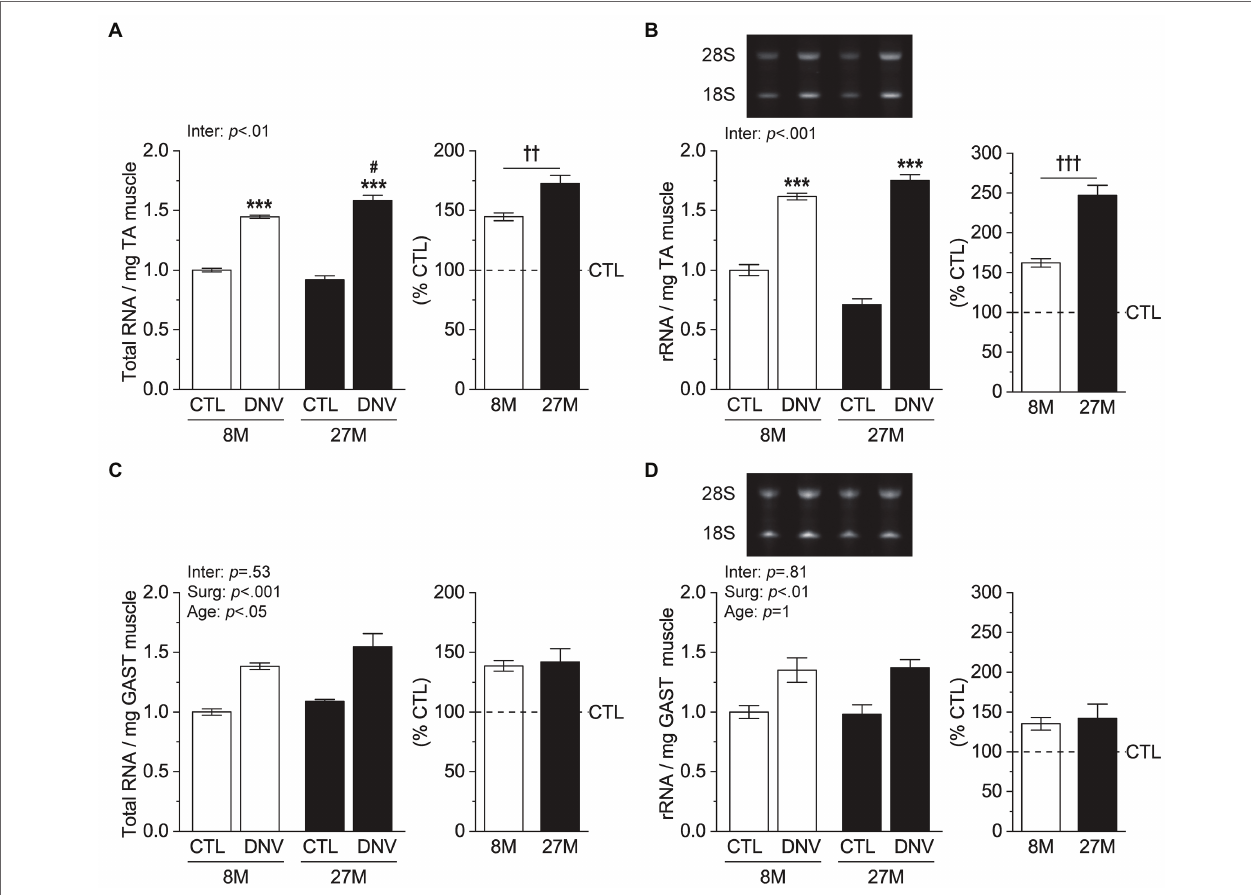
FIGURE 3 | Effects of aging on ribosomal biogenesis during muscle denervation. Mice at 8 months (8 M) and 27 months (27 M) of age were subjected to denervation (right leg, DNV) and sham (contralateral left leg, CTL) surgeries, and TA and GAST muscles were collected 7 days post-surgeries. (A,B) Quantification of total RNA (A) and 28S + 18S rRNA (B) per mg muscle in TA. (C,D) Quantification of total RNA (C) and 28S + 18S rRNA (D) per mg muscle in GAST. n = 4–3 mice/ group. Data are presented as mean ± SEM. and expressed relative to 8 M/CTL or as % of CTL (right panels). *** p < 0.05 vs. CTL by two-way mixed ANOVA. # p < 0.05 vs. 8 M within the same surgery groups by two-way mixed ANOVA. †† p < 0.01 and ††† p < 0.001 by unpaired t test. Inter, interaction between surgery effects (Surg) and age effects by two-way mixed